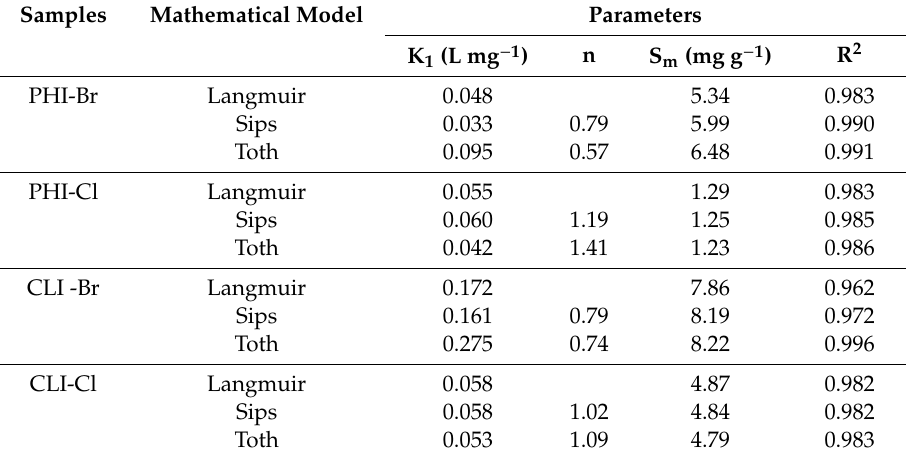
Table 4. Isotherms